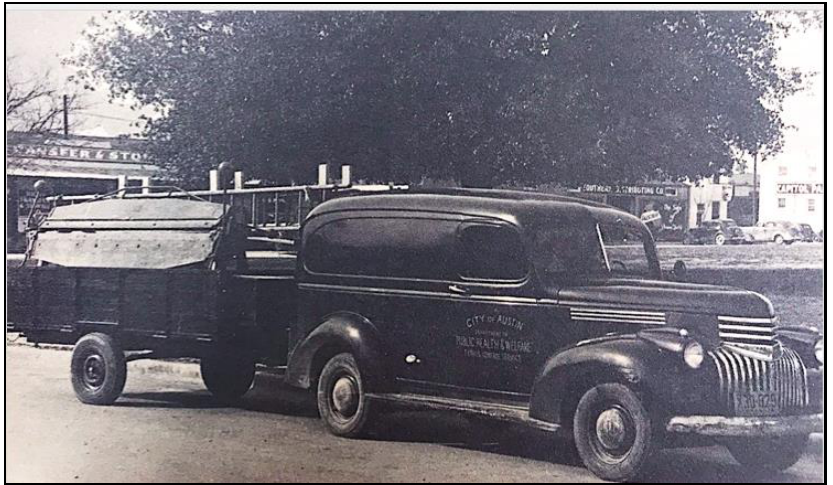
Figure 2. Typhus Control Truck. City of Austin, Dept of Public Health and Welfare, Typhus Control Service. Photograph published in Texas Health Bulletin , July 1949, with the caption “DDT dust, dispensed from spraying units such as the one pulled by the panel truck, destroyed typhus-transmitting fleas within 5–7 days after application to rat runs.”